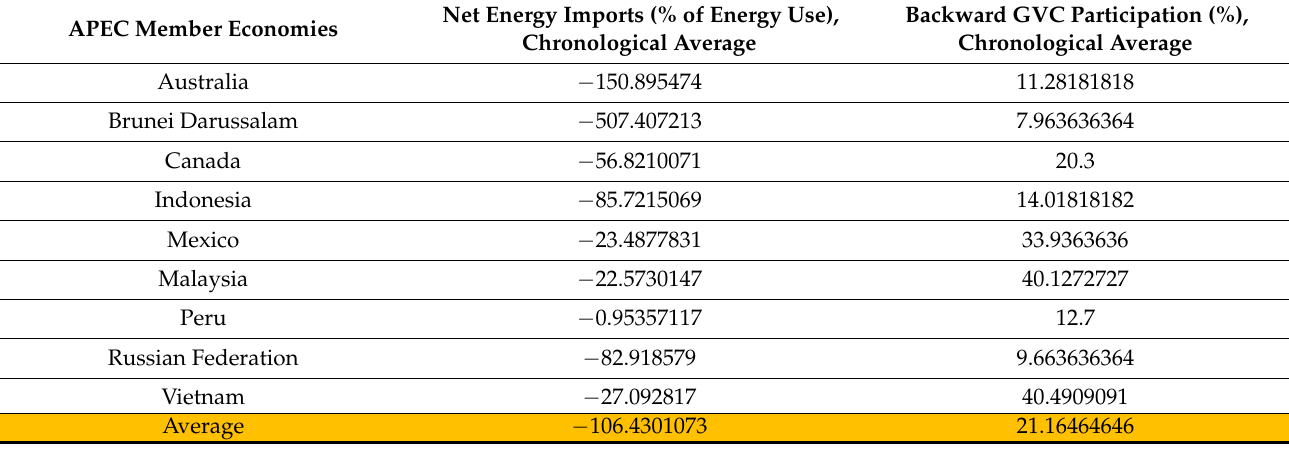
Table 11. APEC member economies—energy